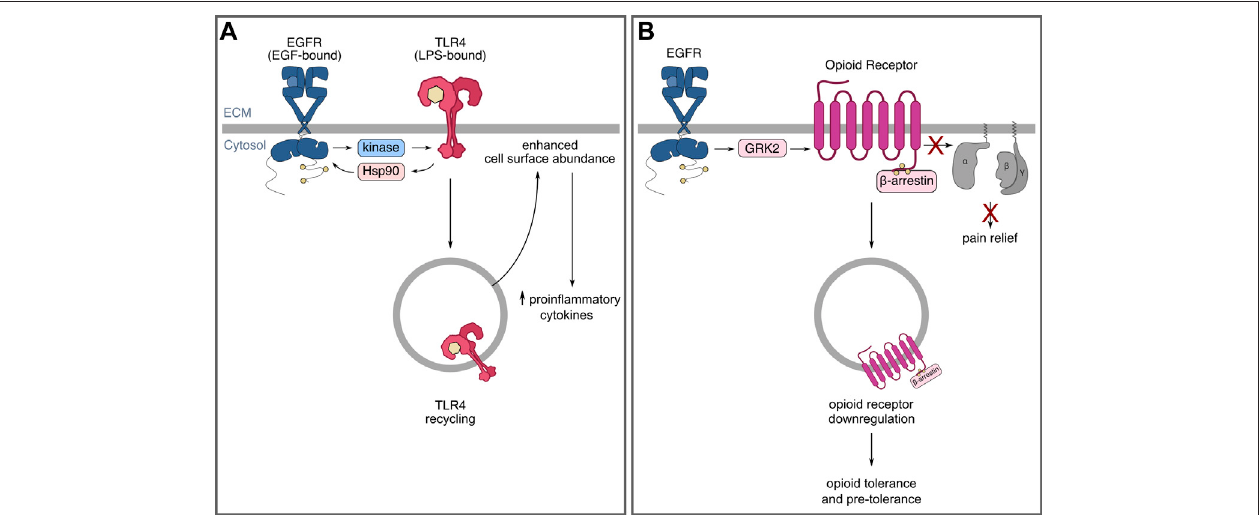
FIGURE 4 | EGFR may modulate immune responses and opioid tolerance by controlling receptor localization and receptor crosstalk. (A) EGFR is required for aspects of TLR4 signalling as well as TLR4 recycling and cell-surface enrichment following LPS stimulation. (B) EGFR and opioid receptor crosstalk leading to opioid receptor internalization and downregulation that may contribute to